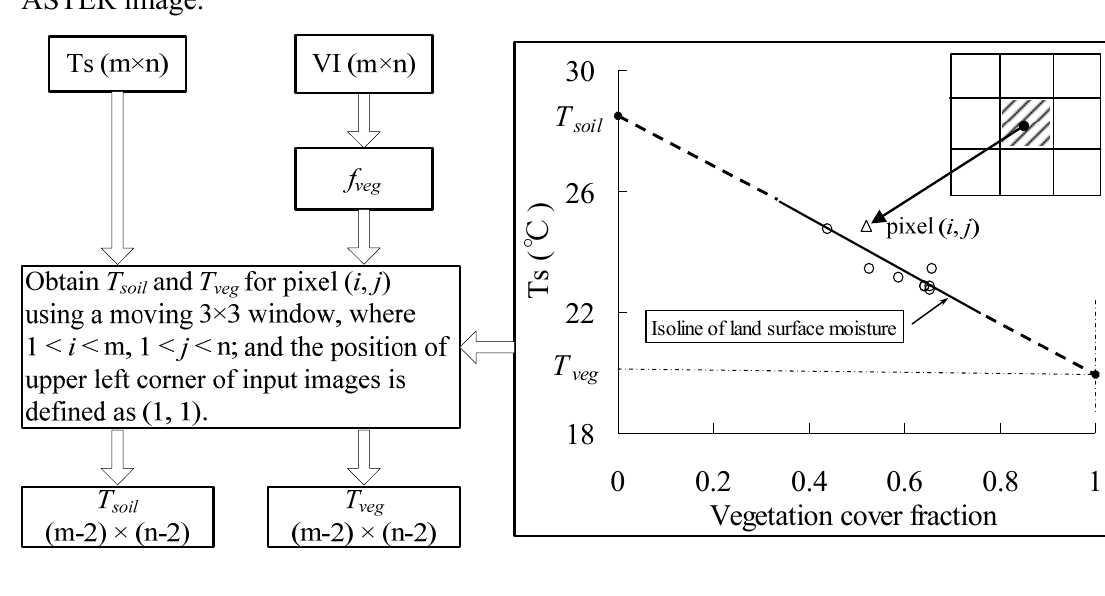
and T of a given pixel by means of 8 neighboring pixels within Figure 5. Obtaining T soil veg a 3 × 3 window. In the right figure, the moving 3 × 3 window was randomly selected in the ASTER